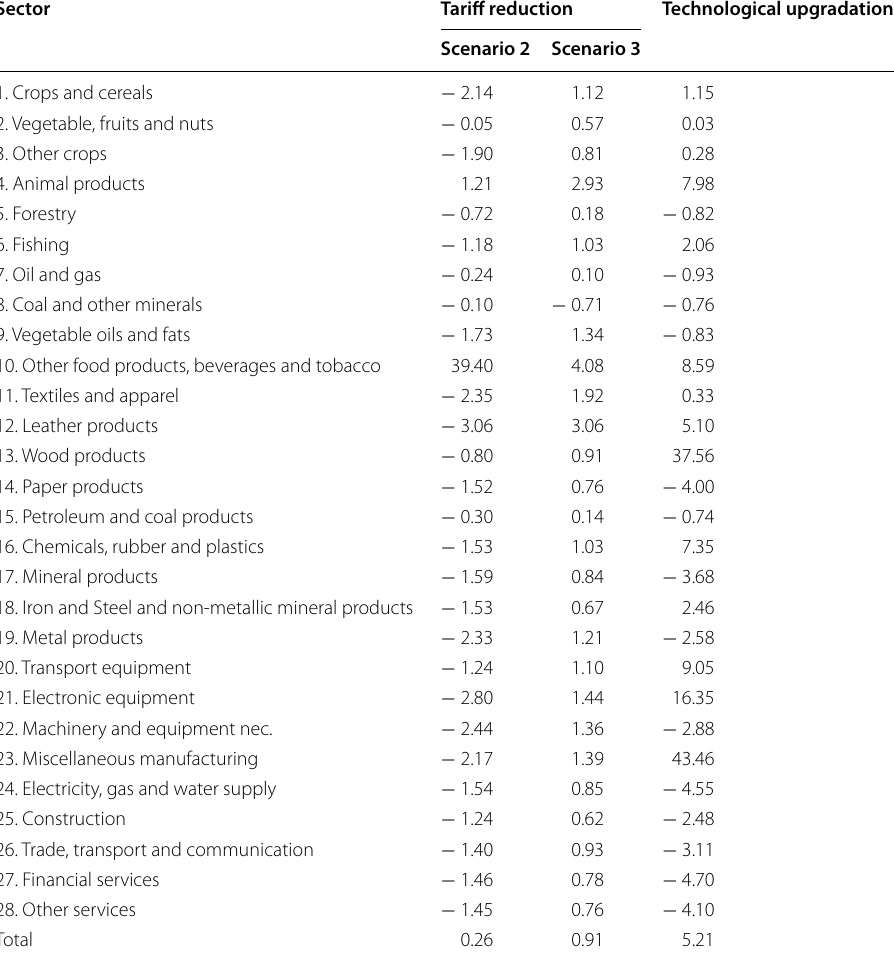
Table 4 Sectoral export growth due to tariff simulation and technological upgradation at 2030 compared to BAU 2030 (USA as TPP